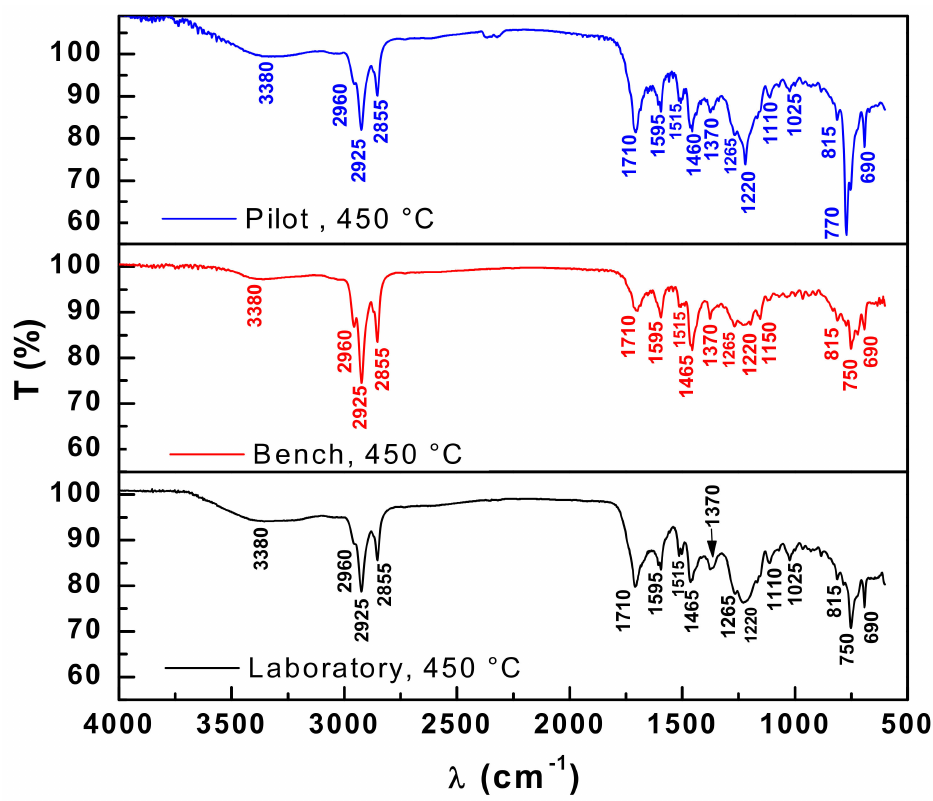
Figure 10. FT-IR of bio-oil obtained by pyrolysis of Aça í seeds pyrolysis at 450 ◦ C and 1.0 atmosphere, in laboratory, bench, and pilot